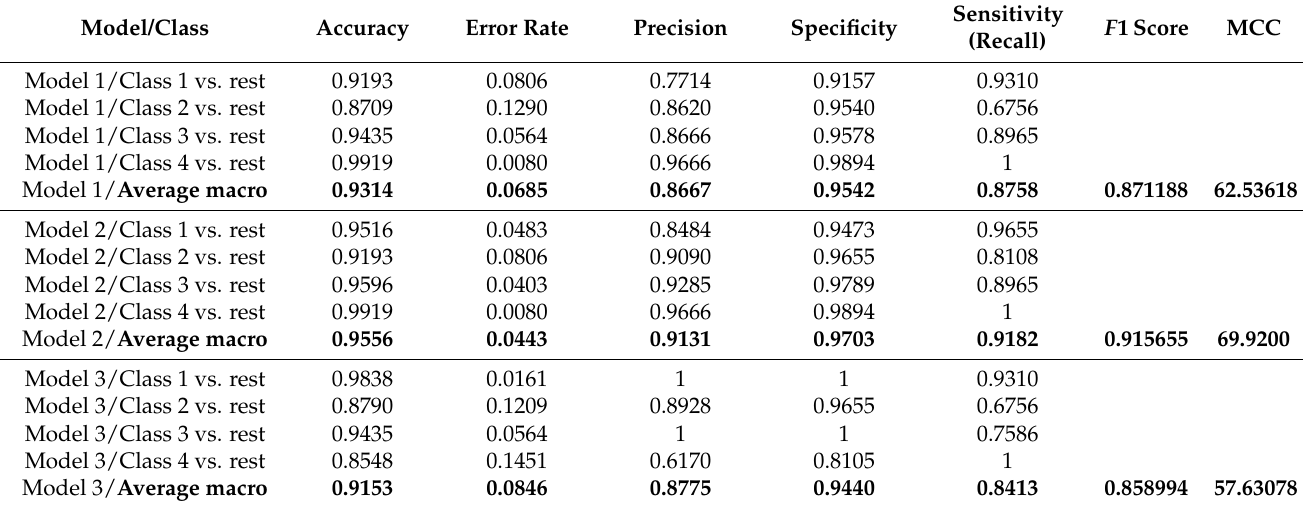
Table 7. Performance metrics of our CNN models 1, 2 and 3 for independent validation (data not seen